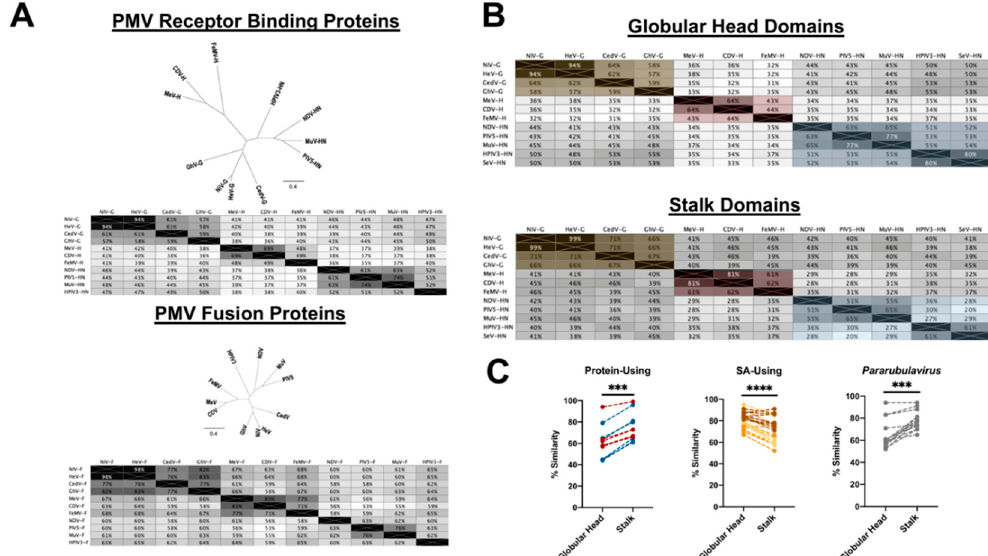
Figure 8. Sequence-based phylogenetic analysis of the PMV glycoproteins reveals glycan-using PMV RBPs have greater conservation in the head domain, whereas the protein-using PMV RBPs have greater sequence conservation in the stalk. Alignments, percent similarity matrices, and neighbor-joining trees were generated using Geneious Prime 2019.2. ( A ) Top, the full length sequences of NiV-G (NP_112027.1), HeV-G (NP_047112.2), CedV-G (YP_009094086.1), GhV-G (YP_009091838.1), MeV-H (P08362.1), CDV-H (NP_047206.1), FeMV-H (YP_009512963.1), NDV-HN (P12554.2), PIV5-HN (YP_138517.1), MuV-HN (AZM68937.1), and HPIV3-HN (P08492.1) were aligned by ClustalW. Scale bar of the neighbor-joining tree indicates 0.4 amino acid substitutions per site. The matrix contains percent similarity values that were calculated using a BLOSUM62 distance matrix with threshold = 0. Bottom, the full length sequences of NiV-F (AAV80428.1), HeV-F (NP_047111.2), CedV-F (YP_009094085.1), GhV-F (AFH96010.1), MeV-F (P69358.1), CDV-F (NP_047205.1), FeMV-F (YP_009512962.1), NDV-F (P12572.2), PIV5-F (P04849.1), MuV-F (AZM68935.1), and HPIV3-F (P06828.2) were aligned by ClustalW. Scale bar of the neighbor-joining tree indicates 0.4 amino acid substitutions per site. Matrix contains percent similarity values that were calculated using a BLOSUM62 distance matrix with threshold = 0. (B) Top, the isolated globular head domain amino acid sequences of the following eleven PMV RBPs were aligned—NiV-G (residues 176–602), HeV-G